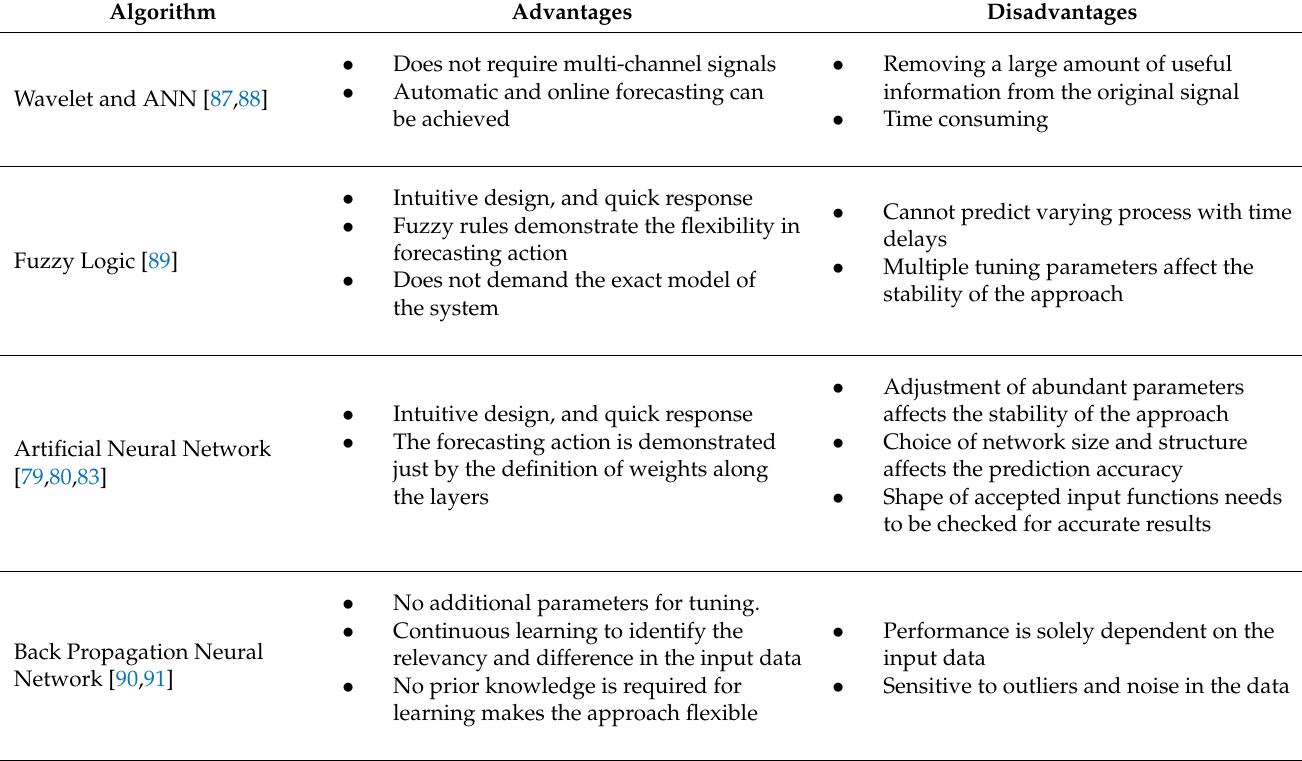
Table 5. Comparison of intelligent techniques for output power